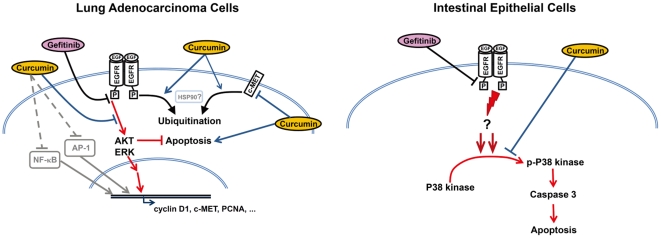
Scheme of the curcumin regulatory effects on lung adenocarcinoma cells and intestine epithelial cells.Curcumin enhances the antitumor effects of gefitinib on lung adenocarcinoma are hypothesized to occur through the induction of EGFR degradation, the blockage of EGFR activation, promoting apoptosis, inhibiting the expression of c-MET, cyclin D1 and PCNA. On the other hand, curcumin attenuates the gefitinib-induced damage on intestinal epithelial cells through modulating p38 kinase activation and cell apoptosis.